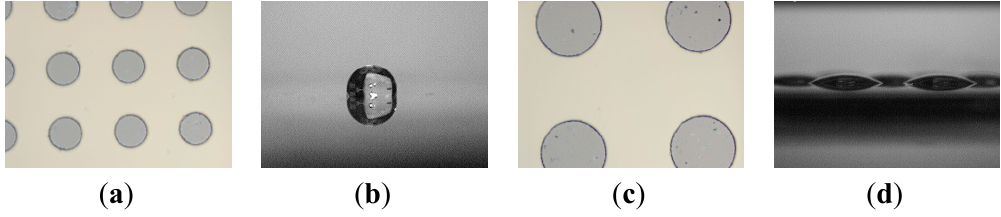
Figure 2. Comparison between large and small patterns. Liquid on the substrate with smaller hydrophilic patterns ( a ) will transform into a single droplet after rupture ( b ) but on the substrate with larger hydrophilic patterns ( c ) will form discrete droplets ( d